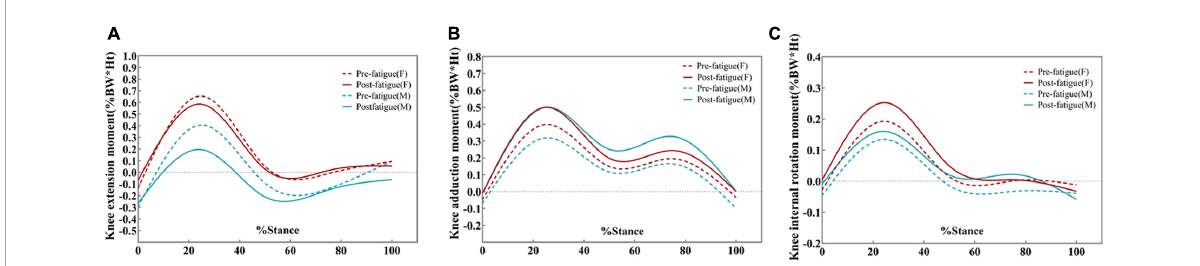
FIGURE8 Ensemble average knee kinetics for the dominant limb for all male and female participants. Changes in knee extension moments (A) , knee adduction moments (B) , and knee internal rotation moments (C) during pre-fatigue and post-fatigue. Moments are given in % bodyweight times height (Ht).